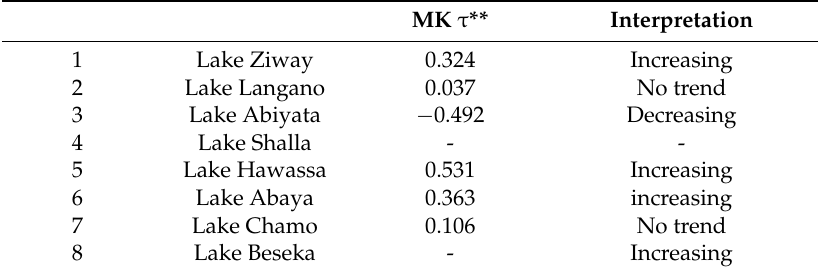
Table 5. Monotonic trends of level of individual lakes. Lake Shalla and Lake Beseka were not analyzed due to limited data